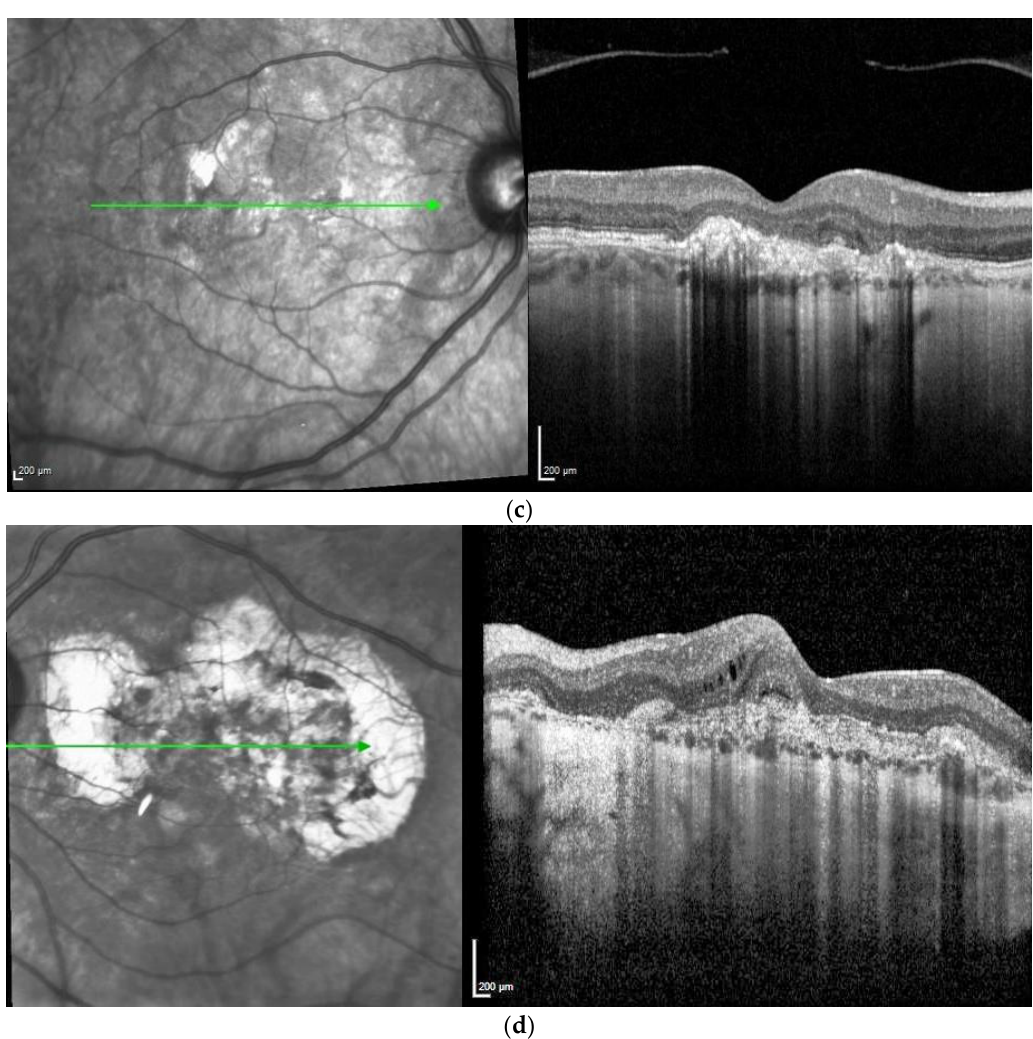
Figure 4. Same patient, 2021, meanwhile 51 years old. Eighteen years after diagnosis and 15 years after the start of intravitreal therapy visual acuity was maintained at Snellen 1.0 (20/20) in his right ( a ) and 0.16 (32/200) in his left eye ( b ), though reading and contrast-enhancing optical aids are required for near visual performance; no lesion activity after 22 intravitreal Ranibizumab injections in the right eye and a widely unchanged macular situation. Progressive macular scarring in both eyes. Upper panel: Clinical pictures of R + L eye ( a , b ), second panel, redfree picture and OCT of the right eye ( c ), bottom same, left eye ( d ). The arrows in redfree frames on the left side in Figure 4c,d indicate the location of the line scans on the right side. Note the progression of severity and extension of RPE changes, Drusen formation and choroidal sclerosis during the observation period. With consequent clinical controls and Ranibizumab treatment immediately upon first signs of lesion reactivation, his quality of life is perceived as excellent, he can follow his daily professional and private activities without relevant restrictions.